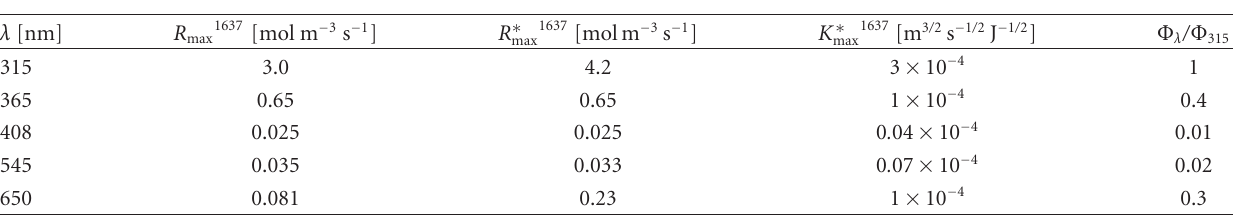
Table 3: (a) R max1637 , R ∗ max1637 , K ∗ max1637 , and Φ λ / Φ 315 measured at 1637 cm − 1 using di ff erent wavelengths of irradiation ( λ ). Sb doping: 7%. a,b / K ∗ / K ∗ (b) R ∗ , K ∗ , K ∗ and K ∗ measured at 1637 cm − 1 , and 1620 cm − 1 using di ff erent wavelengths of irradiation ( λ ). Sb doping: 7%. a,b ini ini ini ini ini max (c) R ∗ and K ∗ measured at 1637 cm − 1 and 1620 cm − 1 di ff erent wavelengths of irradiation ( λ ). Sb doping: 0%. ini ini